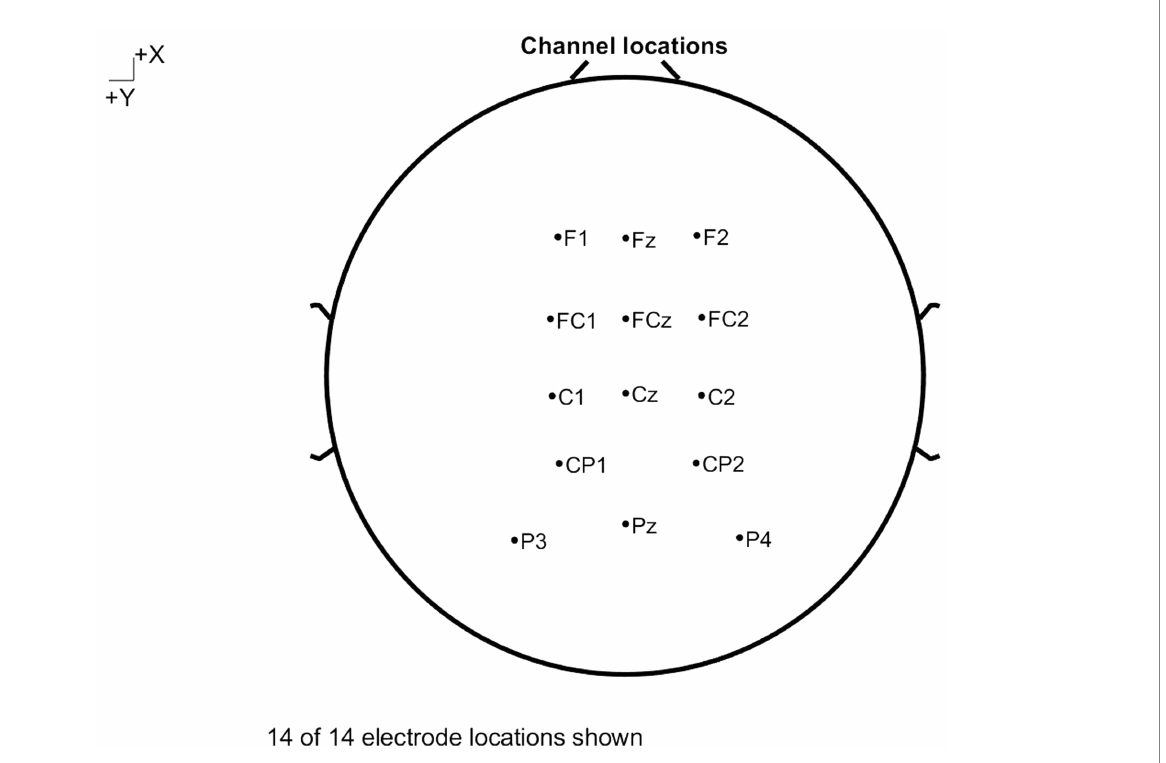
FIGURE 2 Electrode locations